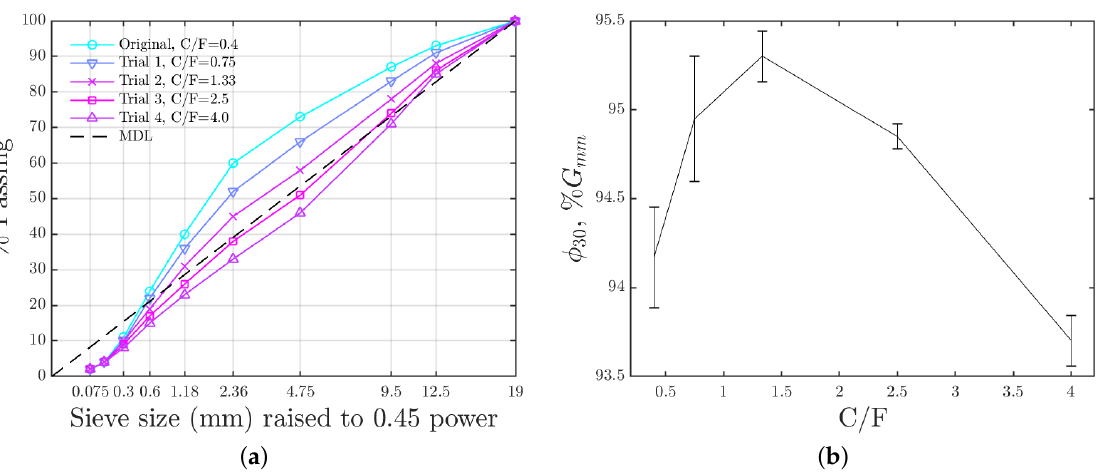
Figure 4. ( a ) Aggregate gradations of the trial blends. ( b ) Densities of the trial blends at 30 gyrations in gyratory compaction. The error bar represents the difference between the two